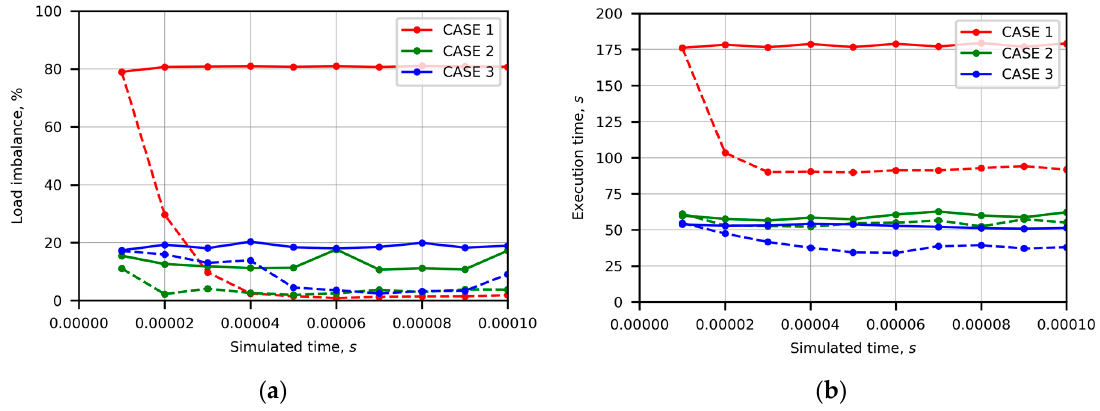
Figure 1. Time evolution of the load imbalance ( a ) and execution time ( b ).